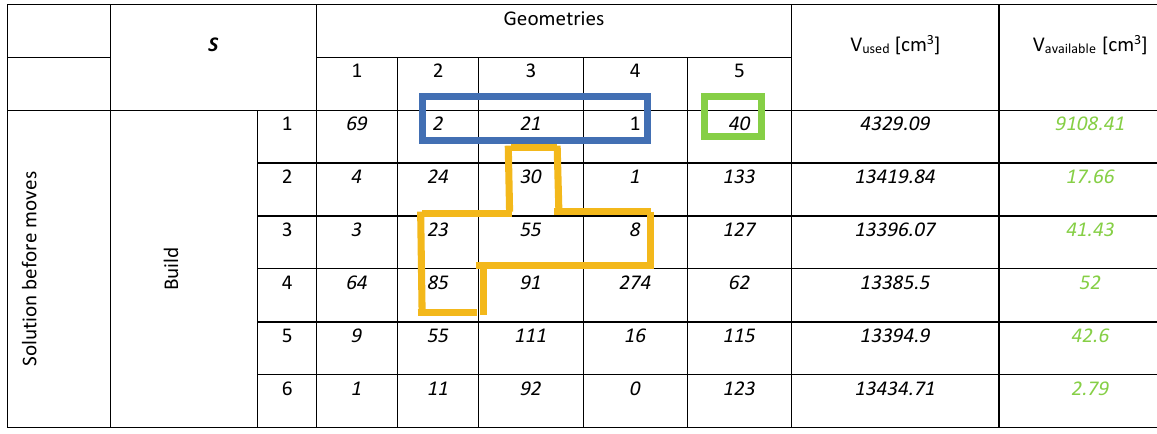
Fig. 7. Volume management 1 of 2